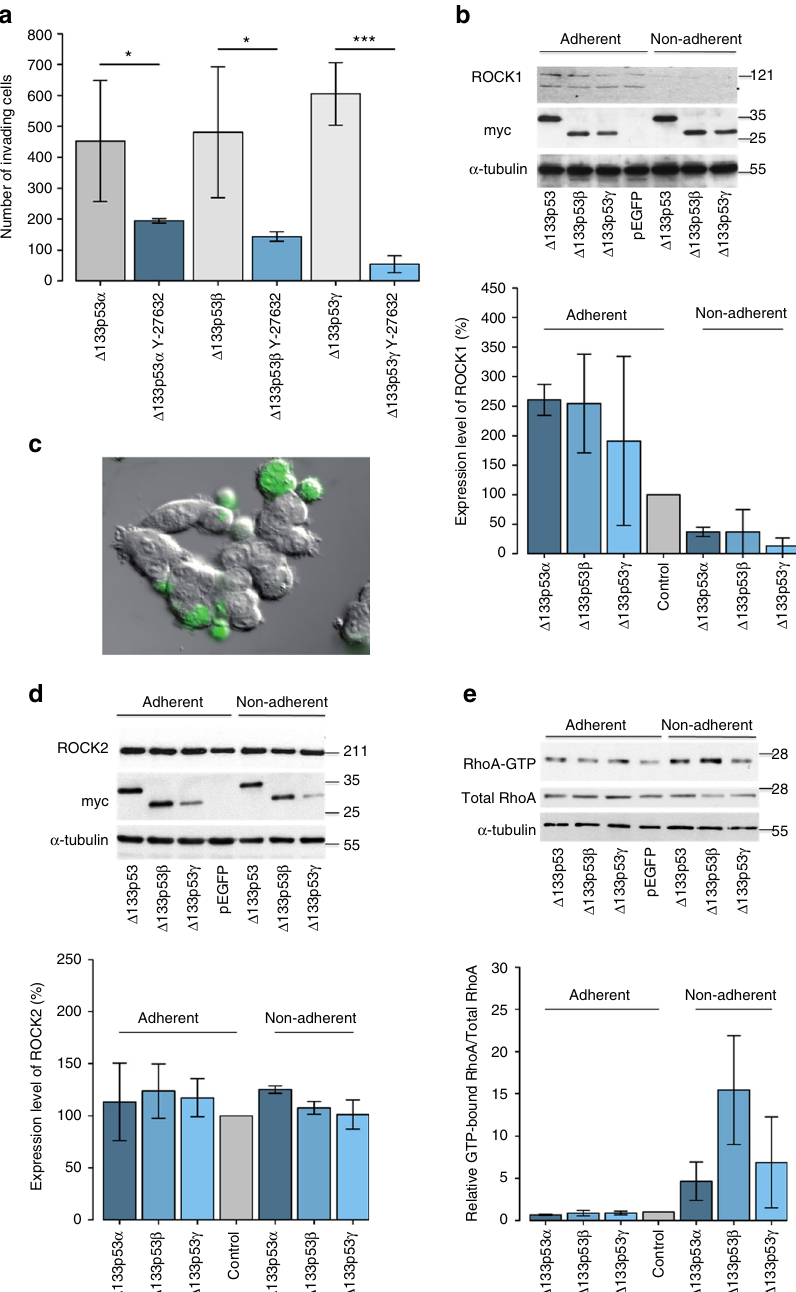
Fig. 6 Invasiveness of HCT116 cells expressing Δ 133p53 ( α , β or γ ) isoforms requires RhoA-ROCK activity. a Quantitative analysis of invasiveness of HCT116 cells expressing Δ 133p53 α , Δ 133p53 β or Δ 133p53 γ in the absence or presence of the ROCK inhibitor Y-27632. After 24 h transfection, cells were treated with 10 µ M Y-27632 and 24 h later invasion assays were performed, with incorporation of Y-27632 into the Matrigel. Values are the mean number of invading cells ± s.d. (error bars); n = 4 independent experiments. b Western blot analysis of the expression of ROCK1 in HCT116 cells expressing the different constructs (control: myc alone; Δ 133p53 α : GFP or myc-tagged Δ 133p53 α isoform; Δ 133p53 β : GFP or myc-tagged Δ 133p53 β isoform; Δ 133p53 γ : GFP or myc-tagged Δ 133p53 γ isoform). Normalisation was performed using an anti- α -tubulin antibody and scanned autoradiographs were quanti fi ed. Values are the mean expression ratios ± s.d. (error bars); n = 3 independent experiments. c Differential interference contrast light microscopy and fl uorescence microscopy of HCT116 cells expressing GFP- Δ 133p53 α showing their rounded appearance. Scale bars = 10 μ m. The total number of transfected (GFP-positive) cells was 46 ± 5.8%, of which 12.6 ± 4.4% were non-adherent. d Western blot analysis of the expression of ROCK2 in HCT116 cells expressing the different constructs as in b and quanti fi cation carried out as in b . e RhoA activity in cells described in b . RhoA abundance was evaluated by western blotting. Results represented as the ratio of activated RhoA (GTP-bound RhoA) protein divided by total RhoA protein level. Values are the mean ± s.d. (error bars) of n = 3 independent experiments. p < 0.05 was considered signi fi cant. * p < 0.05 and *** p < 0.0005 are designated,